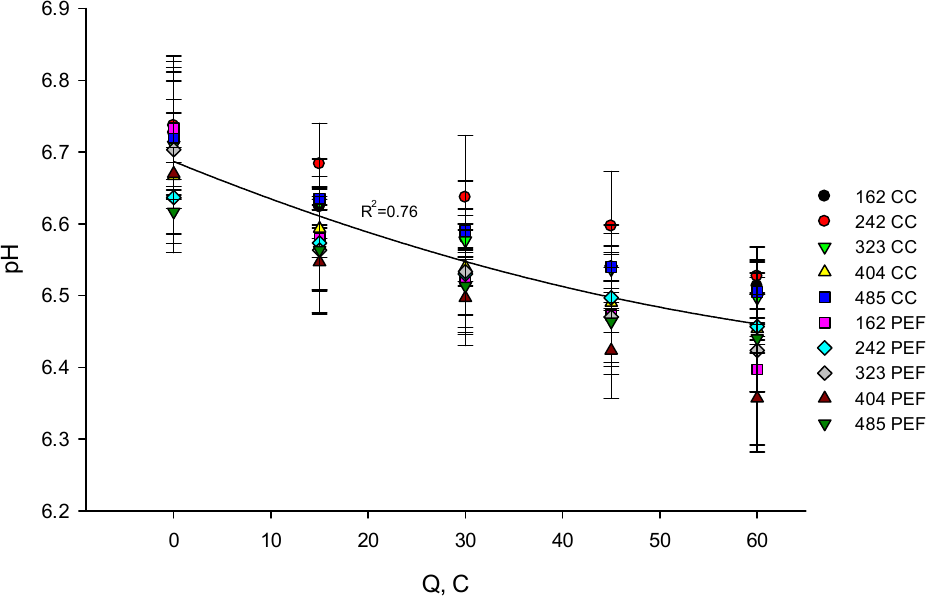
Figure 2. Evolution of milk pH as a function of the number of charges transported (in Coulomb) during EDBM carried out in different conditions of flow rate (corresponding to indicated Reynolds numbers) and current mode. Reynolds numbers of 162, 242, 323, 404 and 485 correspond to flow rates of 400, 600, 800, 1000 and 1200 mL/min respectively. CC—constant current and PEF—pulsed electric field.